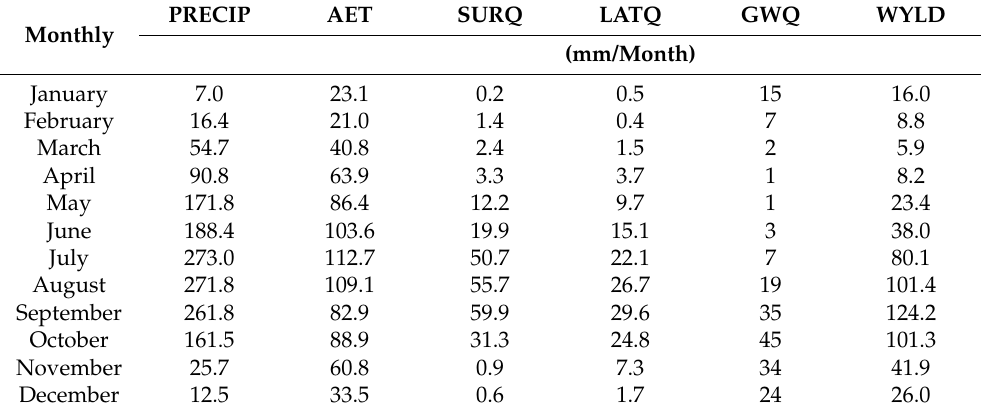
Table 5. Average monthly water balance components for the baseline period from 2000 to 2019.